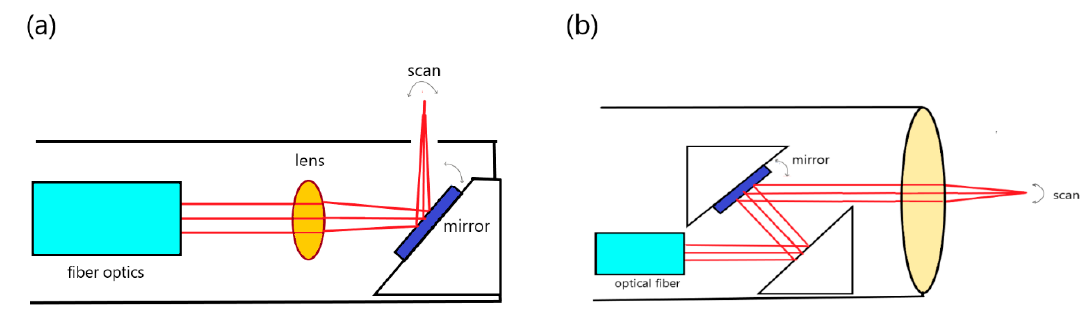
Figure 6. Two categories of miniature OCT probes: ( a ) side imaging probe; and ( b ) forward imaging probe.